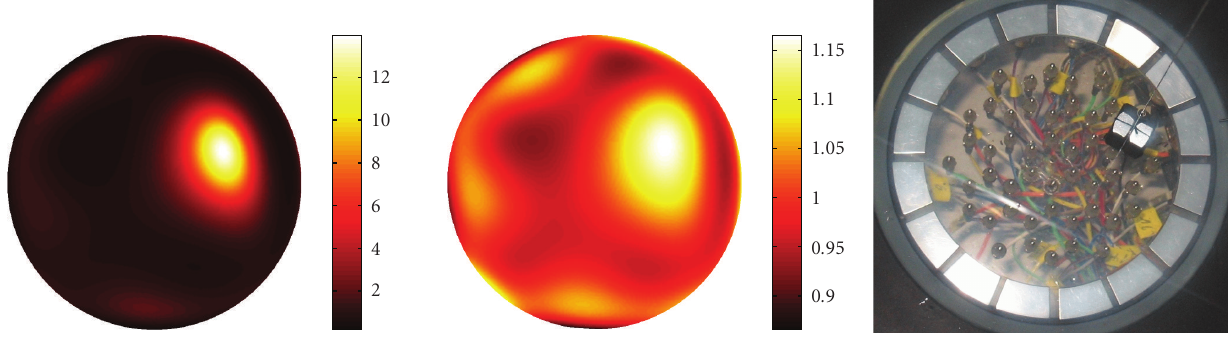
Figure 3: Top: Reconstructions with di ff erence (left) and absolute data (right). Bottom: Phantom used for these two